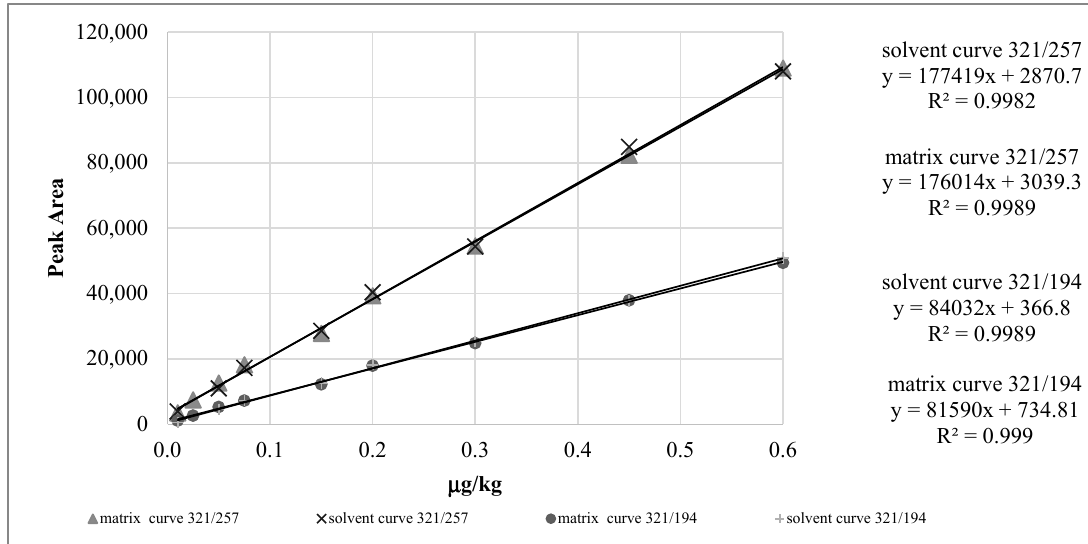
Figure 3. Comparison between calibration curve in solvent and in matrix at the same concentration range for 321 → 257 and 321 → 194 ion transitions.